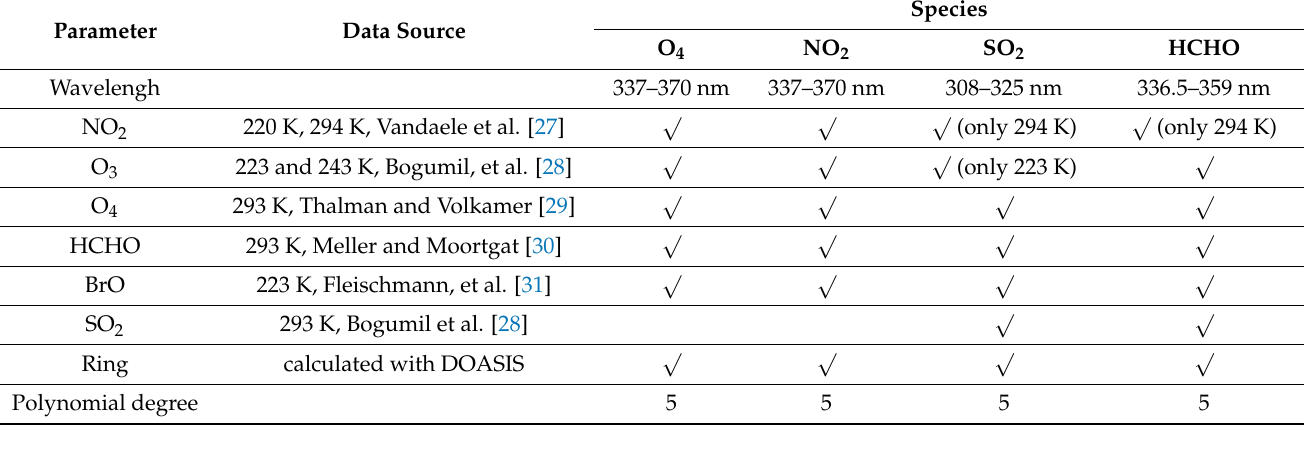
Table 2. QDOAS parameter settings.